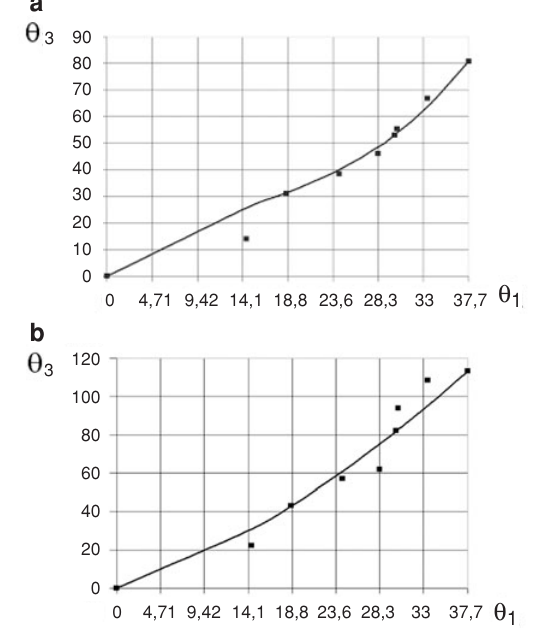
Figure 5 Numerical evaluation of the test in Figure 4 in the form of experimental measures as square cubic dots and as cubic line interpolation by referring to the scheme of Figure 3: (a) θ 2 vs. θ 1 ; (b) θ 3 vs. θ 1 . angle joint of first phalanx that is the input 1 d.o.f.